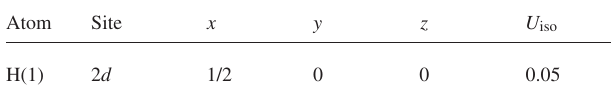
Table 2. Atomic coordinates and displacement parameters (in Å 2 ) .